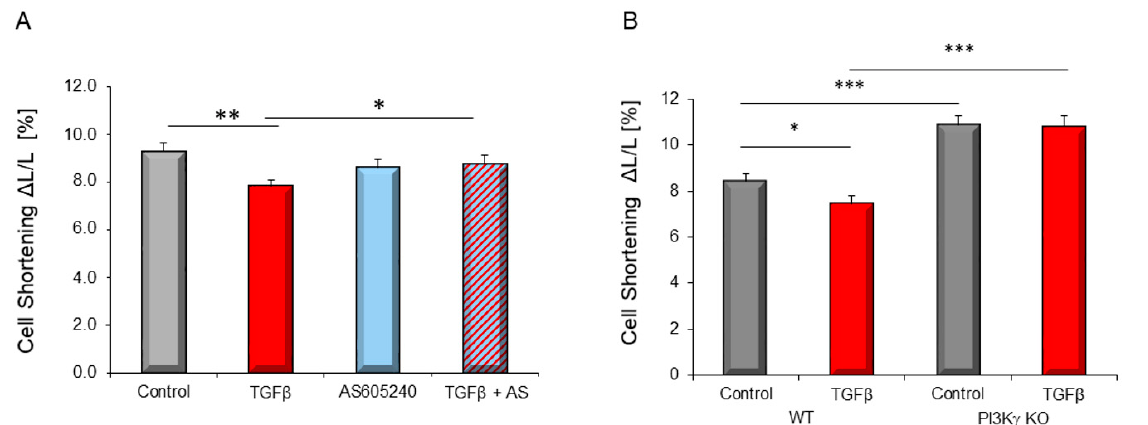
Figure 5. ( A ) Contractile function of isolated cardiomyocytes of adult rats. Cardiomyocytes were incubated with TGF β 1 (1 ng/mL) for 24 h, with and without addition of PI3K γ inhibitor AS605240 (100 nM), afterwards stimulated with 2 Hz and contractile parameters were measured. Data are mean ± SEM of 54 cells of six independent cardiomyocytes preparations. ( B ) Contractile function of isolated cardiomyocytes of PI3K γ KO and WT mice. Cardiomyocytes were incubated with TGF β 1 (10 ng/mL) for 24 h, afterwards stimulated with 2 Hz and contractile parameters were measured. Data are mean ± SEM of 6–10 different cell dishes with 54 to 90 cells. dL/L: shortening amplitude normalized to diastolic cell length (amplitude × 100/L Diast). Significance is indicated by * p < 0.05, ** p < 0.01 and *** p < 0.001. Two-way ANOVA: WT versus PI3K γ KO p < 0.0001.